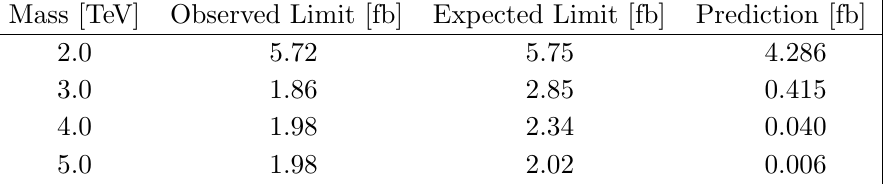
, as well as the predicted cross-section radion